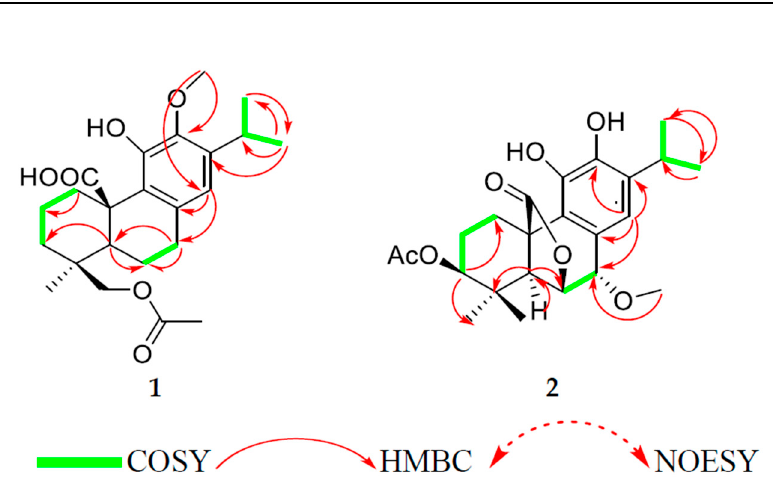
Figure 2. Key 1 H − 1 H correlation spectroscopy (COSY), heteronuclear multiple bond correlation (HMBC), and nuclear Overhauser effect spectroscopy (NOESY) correlations of 1 and 2 . Compound 5 was isolated as a white powder. The HRMS data indicated an ion peak at [M]